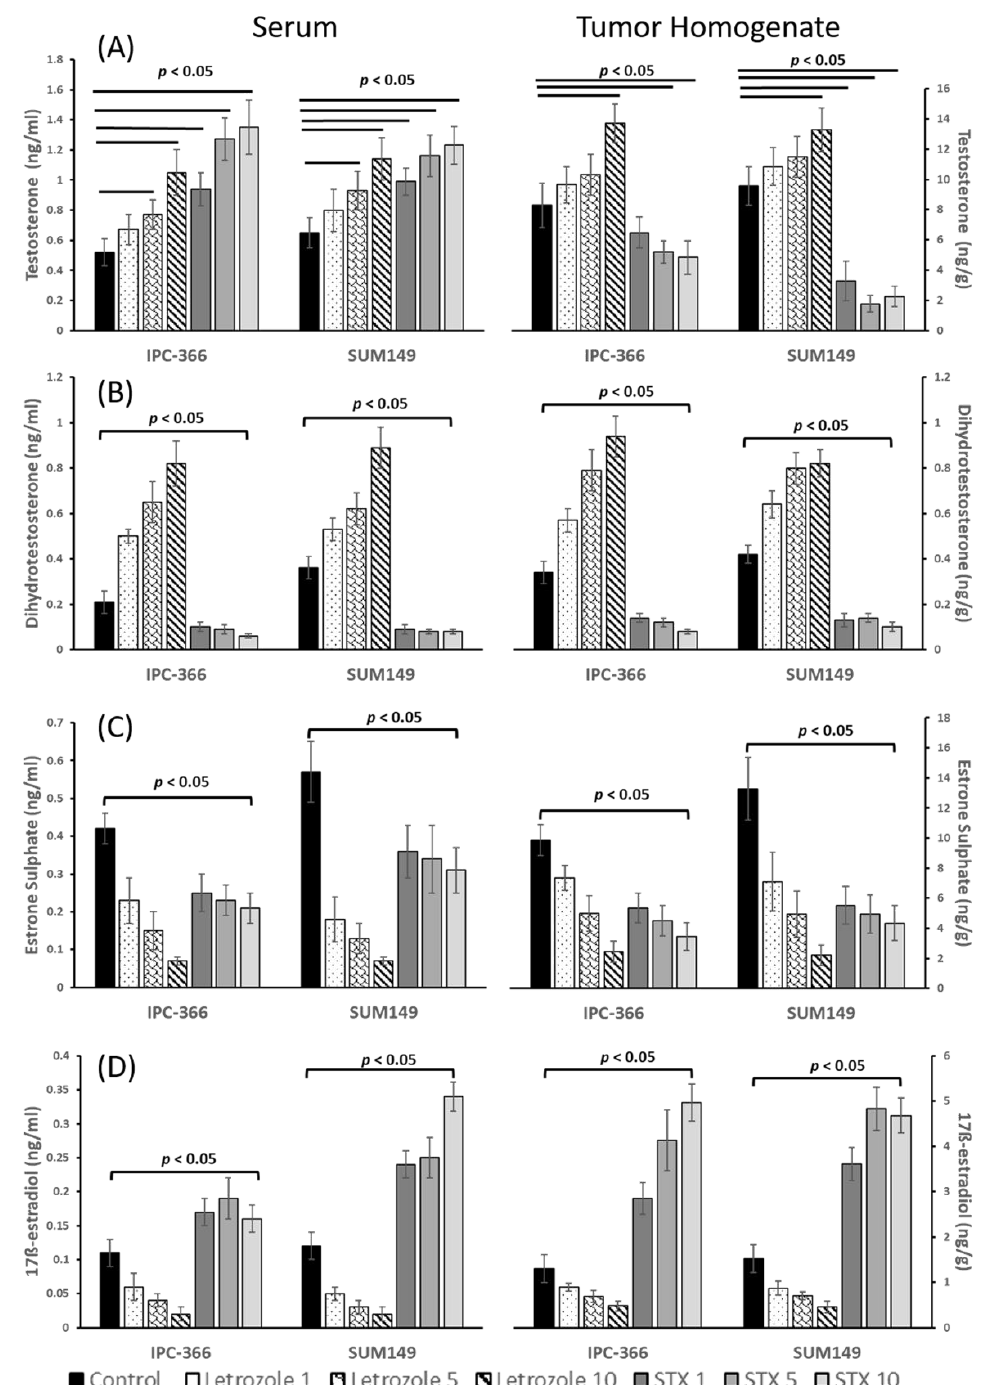
Figure 5. Steroid concentrations of ( A ) Testosterone (T); ( B ) Dehydrotestosterone (DHT); ( C ) Oestrone sulphate (SO4E1) and ( D ) 17 β -oestradiol (E2 in serum and tumor homogenate samples of treated xenografts from IPC-366 and SUM149. Results showed an increased in androgen concentrations and a decrease in estrogen concentrations on serum and tumor samples of xenografts treated with letrozole and STX-64. Bar represents means ± SD. significant differences between control and treated groups ( p < 0.05).